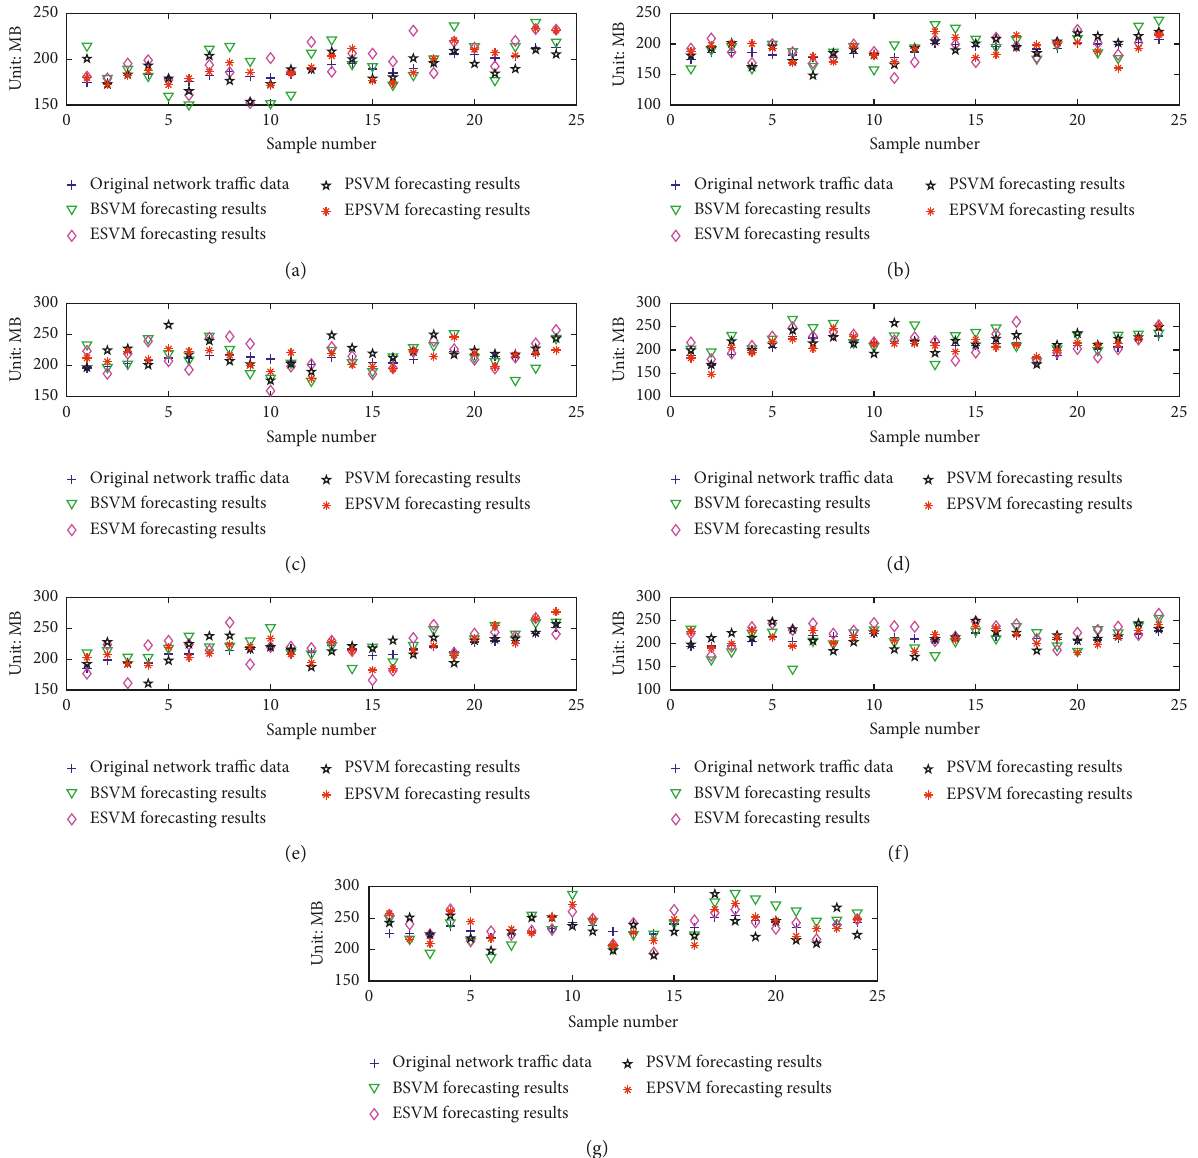
Figure 7: Forecasting result of inflow NTD at LZU network center: (a) Monday, (b) Tuesday, (c) Wednesday, (d) Thursday, (e) Friday, (f) Saturday, and (g)